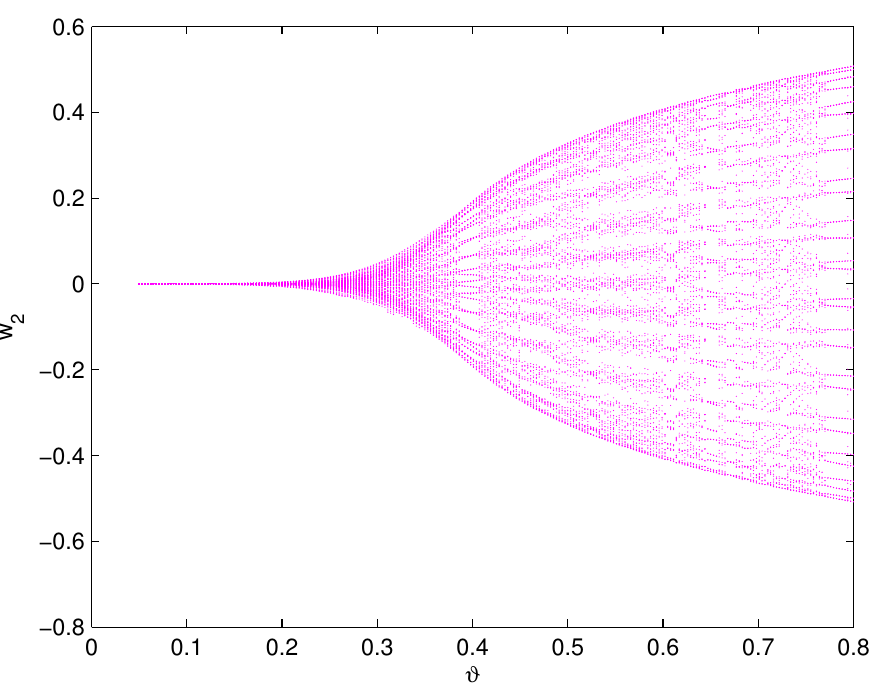
Figure 4. Bifurcation graph of system (71): the delay ϑ versus the variable w 2 . The bifurcation number is 0.37.